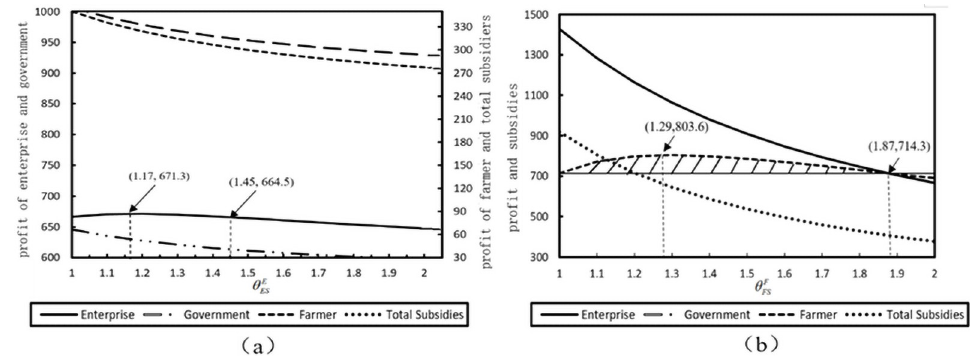
Fig 2. The impact of misreporting level on the profit of members in the supply chain.